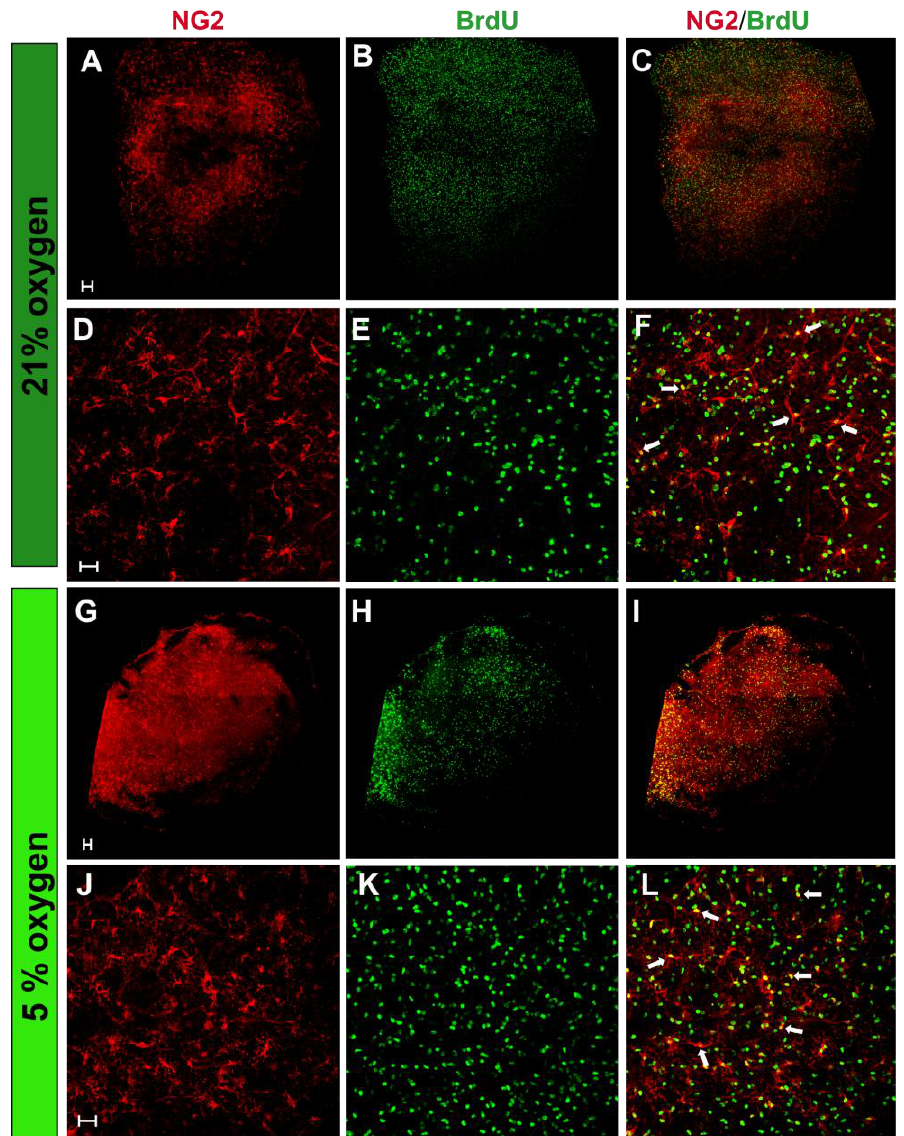
Figure 7. Hippocampal organotypic slices cultured either in standard ( A – F ) or physiologically normoxic ( G – L ) conditions. Oligodendroglial progenitors were stained with anti-NG2 antibody ( red ), while proliferating cells were visualized by BrdU (5-bromo-2′-deoxyuridine) incorporation ( green ). Double-labelled cells (white arrows) indicate the newly generated oligodendrocytes in the slices during a 7 day long culture in serum-free medium. The scale bar is equivalent of 50 µm.